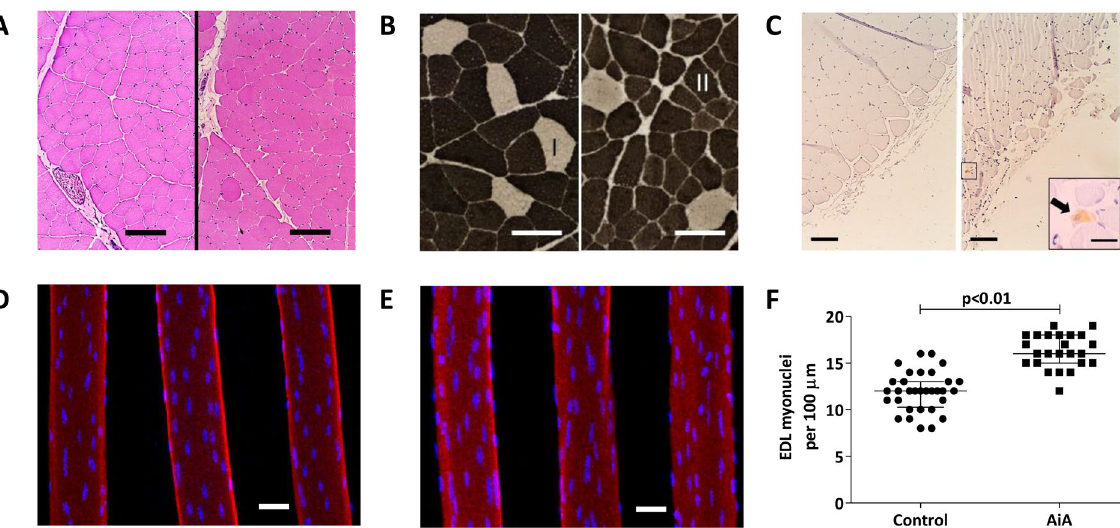
Figure 3. Histological alterations in skeletal muscle. ( A ) Representative sections of tibialis anterior (TA) of control (left) and AiA (right) rabbits. Carazzi haematoxylin and eosin staining. Scale bar = 100 μ m. ( B ) Representative sections of type I (white) and II (black) fiber distribution and size in TA of control (left) and AiA (right) animals stained with ATPase pH 9.4. Scale bar = 100 μ m. ( C ) Representative TA cross-section with RAM11 immunostaining of control (left) and AiA (right) groups. Scale bar = 100 μ m. Inset showed RAM11 immunoreactive cell (black arrow) beneath the epimysium in AiA. Scale bar = 25 μ m. ( D – F ) Representative focal microscopy images from segments of extensor digitorium longus (EDL) fibers in control ( D ) and AiA rabbits ( E ). Rhodamine phalloidin (red) was used to stain actin and DAPI (blue) to stain nuclei. Scale bar = 30 µ m. ( F ) Myonuclei number in control in comparison to AiA group expressed as number of nuclei per 100 mm of fiber